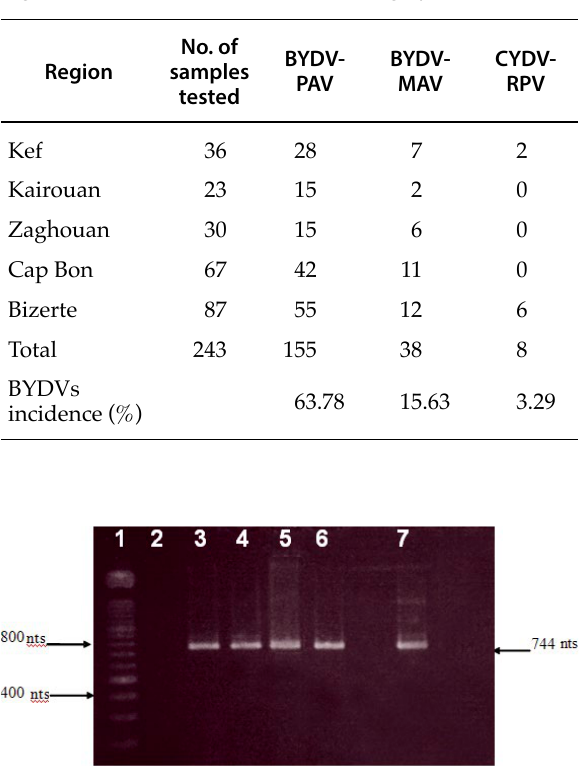
Table 2 . BYDVs incidence (%) in barley fields of different regions in Tunisia based on virus testing by DAS –ELISA.